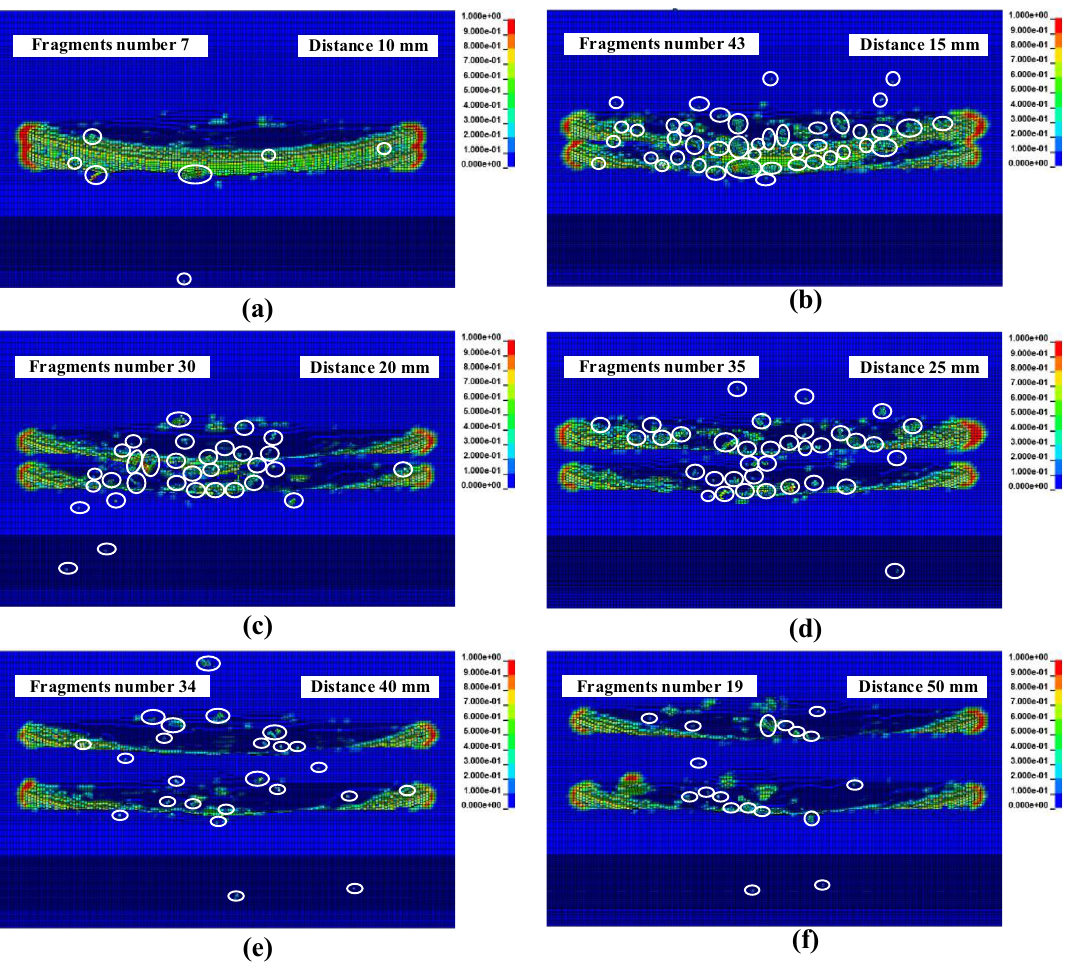
Figure 13. Rock fragments with various spacings between double circular saw